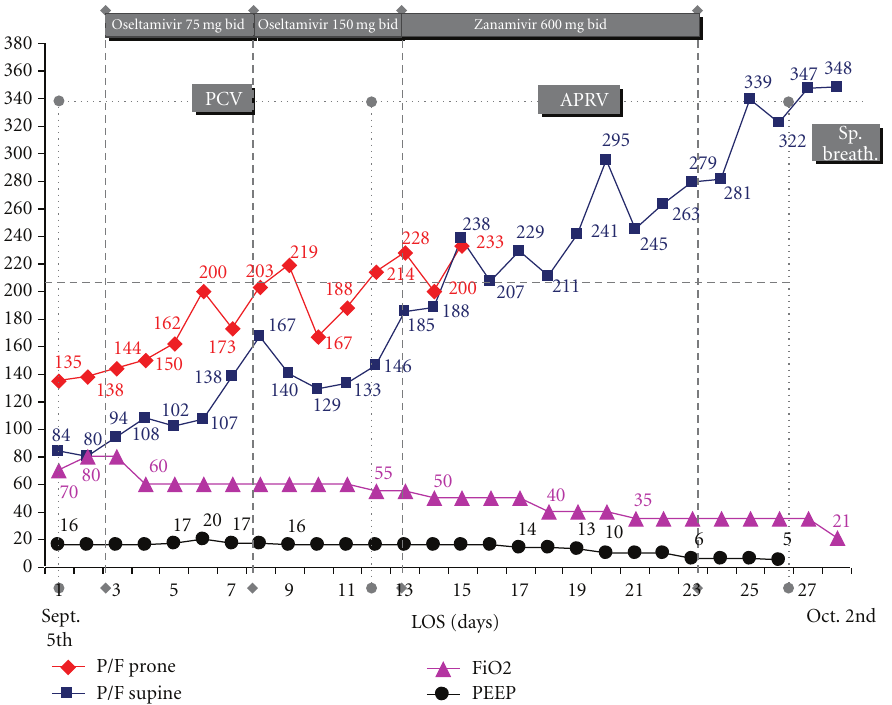
Figure 1: Correlation among P/F values in supine and prone positions, PEEP levels, and ventilation